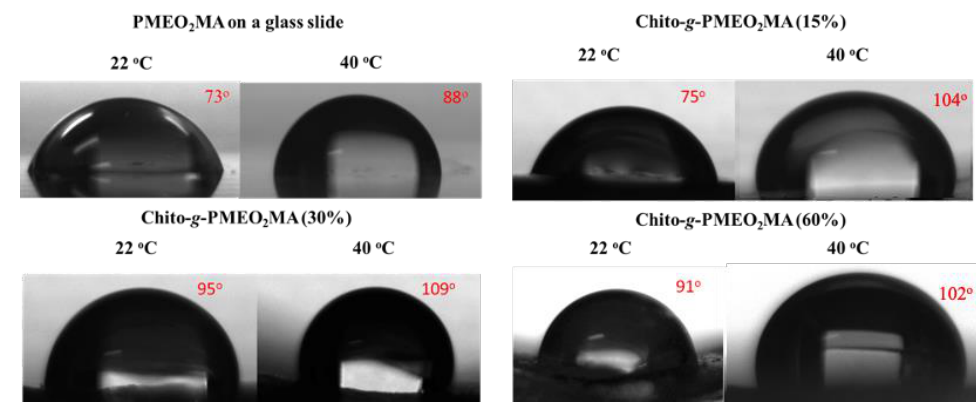
Figure 3. Contact angle measurements at t = 0 s for different samples at 22 and 40 °C.